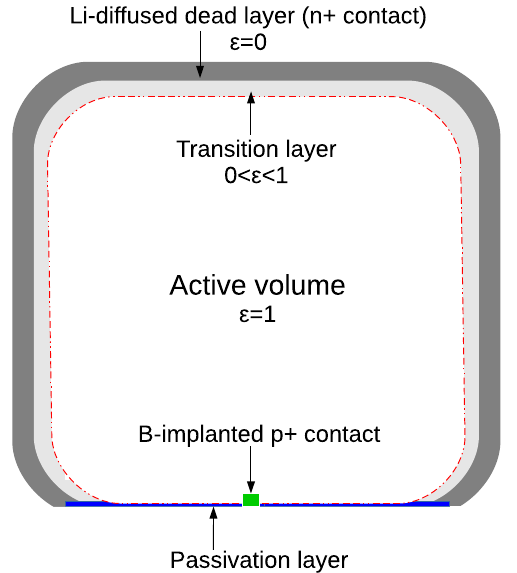
Fig. 3 PPC HPGe diode design adopted for the Conus detector pro- duction. Both height and diameter are 62mm. Diode regions with dif- ferent efficiencies ε in signal detection are labeled